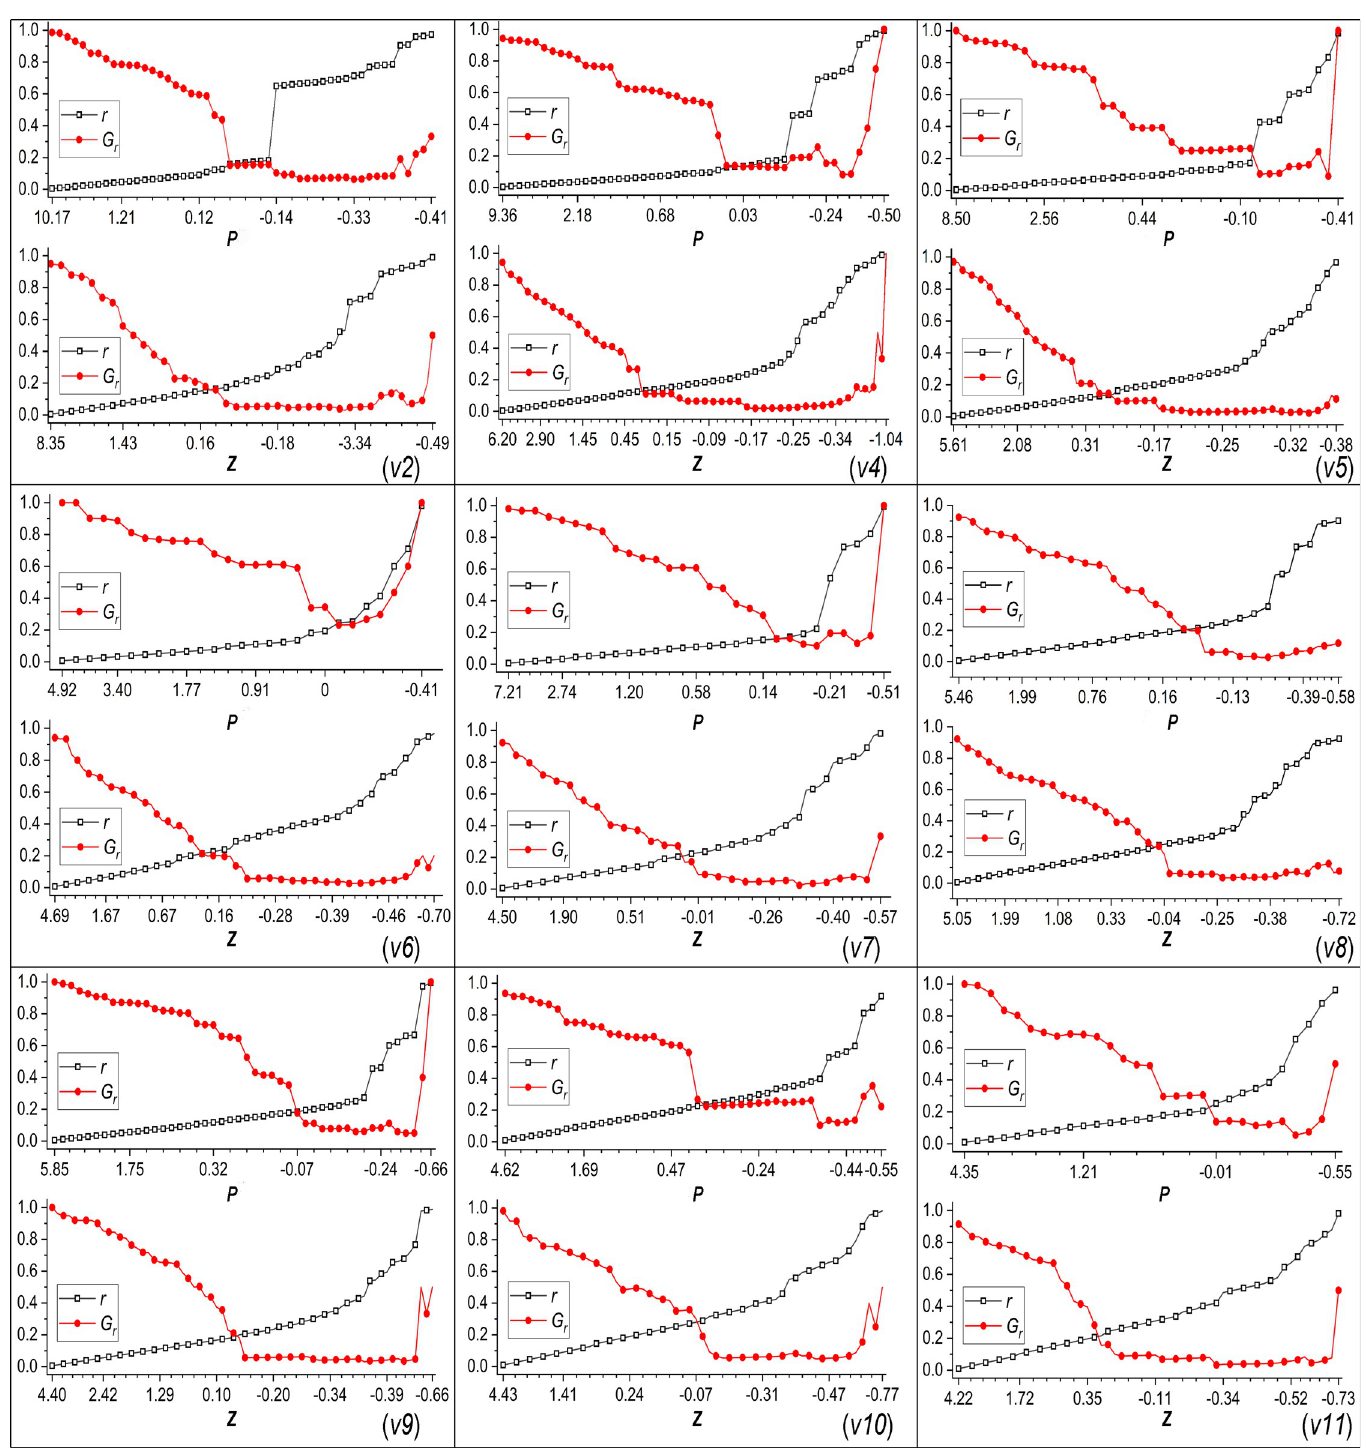
Fig 6. Changes in network connectivity during node removal